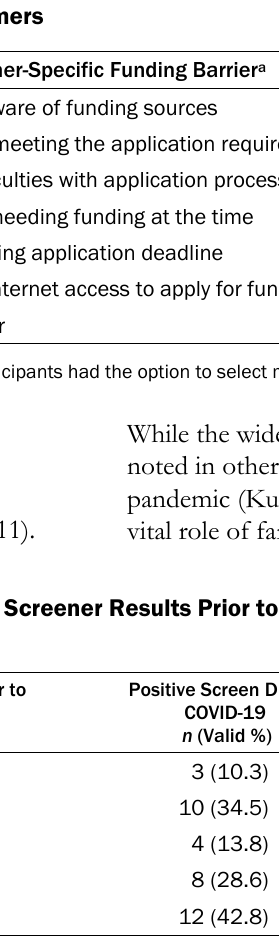
Social Needs Screener